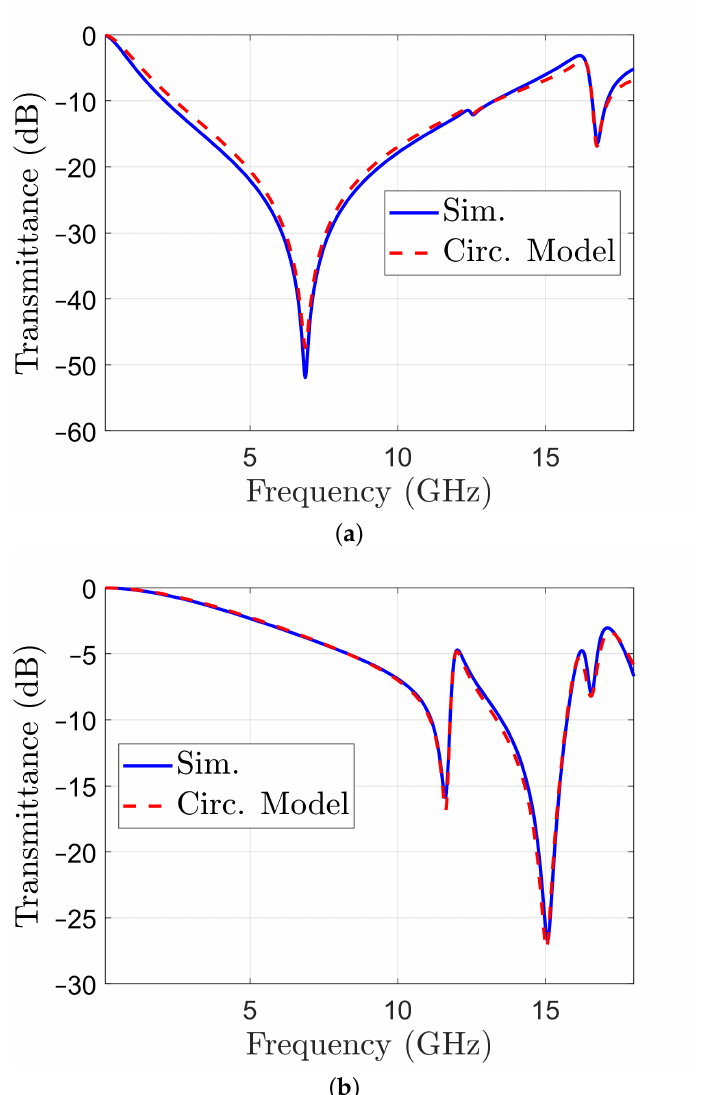
Figure 7. Transmittance of structure with metal pattern on one face only: calculated with the circuit model of the unit cell (dashed line) and obtained by simulation (solid line): ( a ) Face 1; ( b ) Face